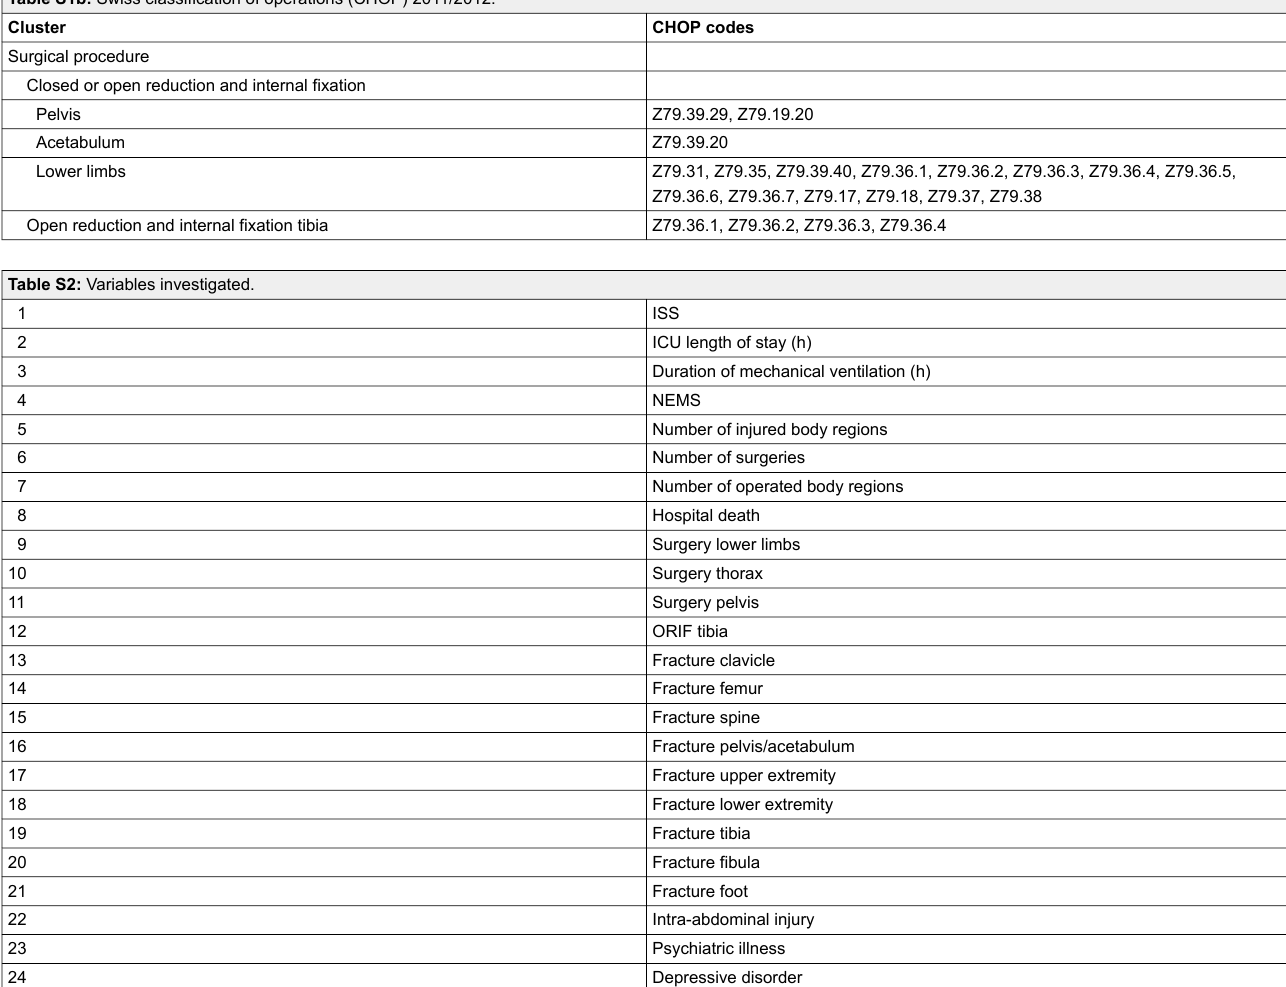
Table S2: Variables investigated.